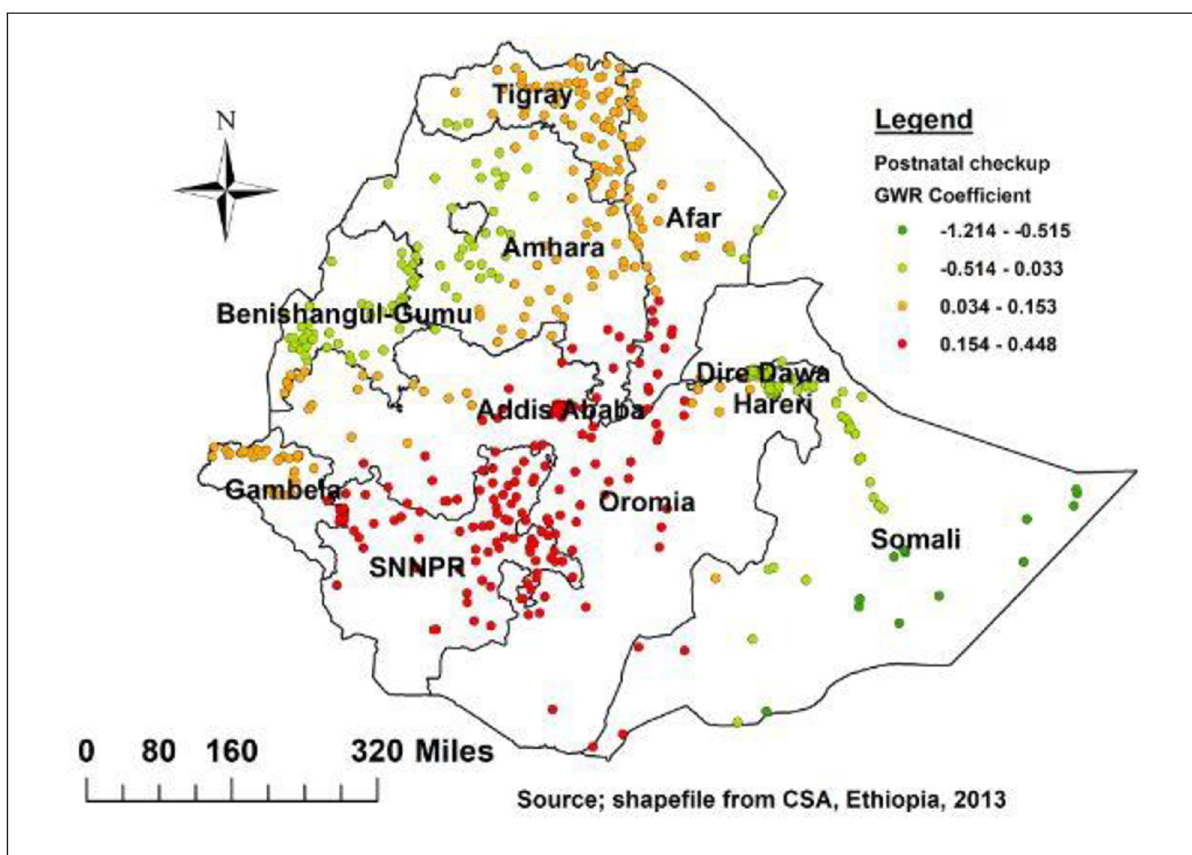
Fig 9. Baby postnatal checkup geographic weighted regression coefficients to predict delayed breastfeeding in Ethiopia.